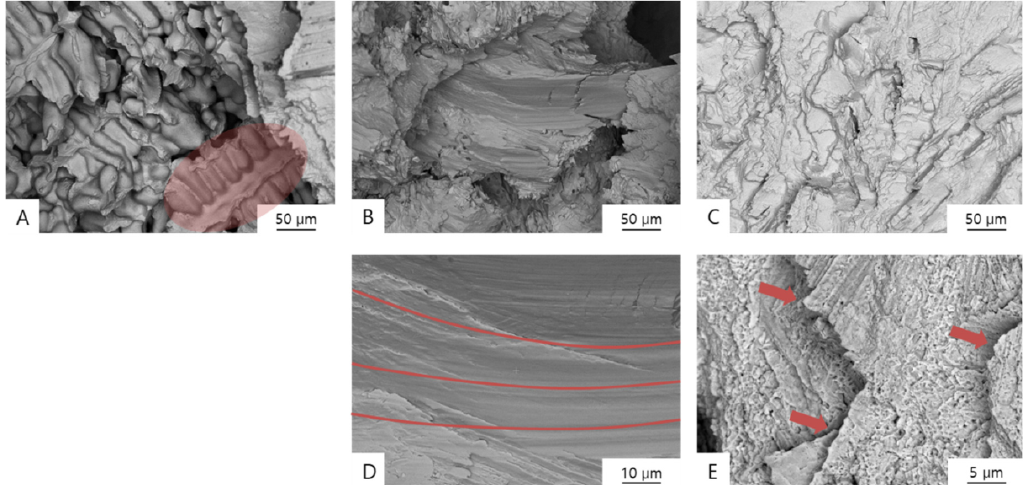
Figure 7. Backscattered electron (BSE) images of the fractured surfaces of Co-Cr alloy specimens formed by means of ( A ) casting (1000 × ; red shaded area indicates a dendritic structure), ( B ) milling (1000 × ), ( C ) SLM, (100 × ), ( D ) milling (5000 × ; red lines signify striations), and ( E ) SLM (10,000 × ; red arrows indicate cleavage